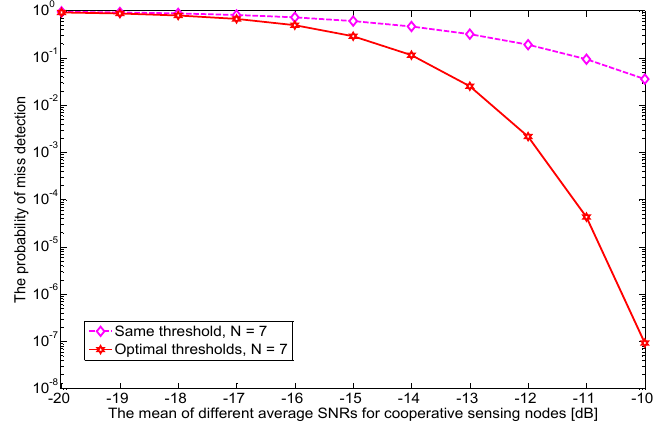
Figure 8. The probability of miss detection for two different thresholds methods are shown when the mean of different average SNRs of cooperative sensing nodes increases; the target P f = 1% and N =